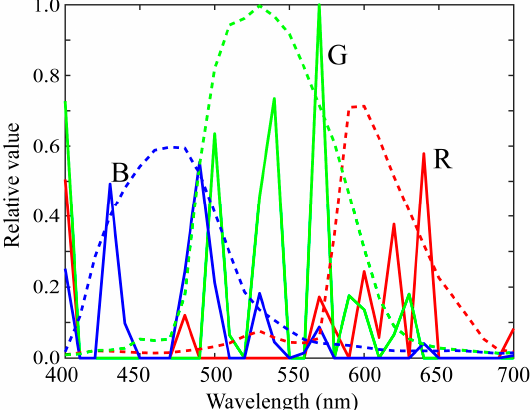
Figure 12. Estimation results from the normal method for the iPhone 8, where the bold curves in red, green, and blue represent the estimated spectral sensitivities for the red, green, and blue channels, respectively, and the broken curves represent the measured spectral sensitivities used as the reference data.